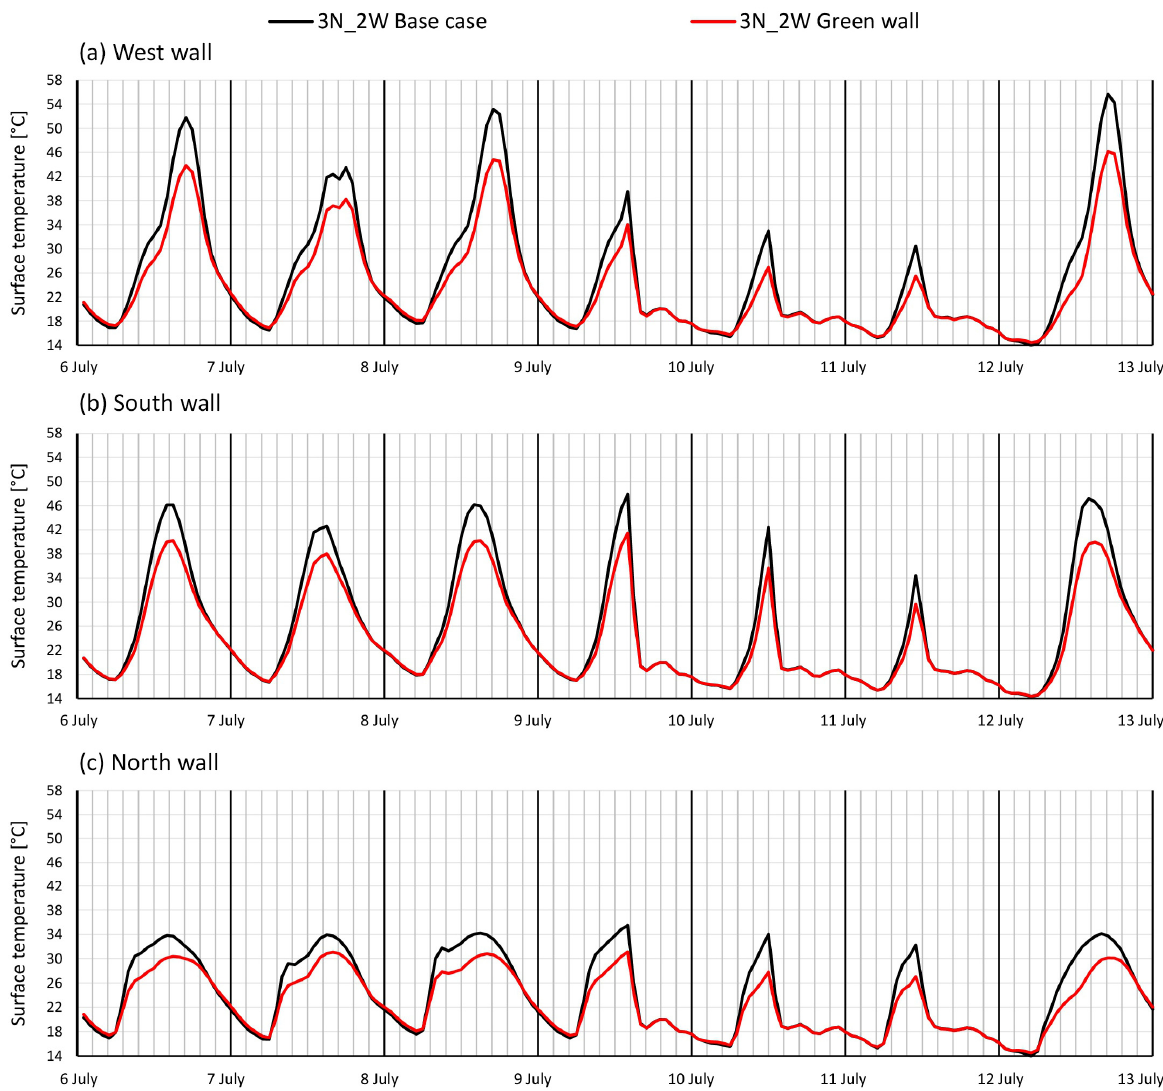
Figure 2. Trend of the external surface temperature (°C) in the summer reference week for ( a ) western, ( b ) southern and ( c ) northern walls.